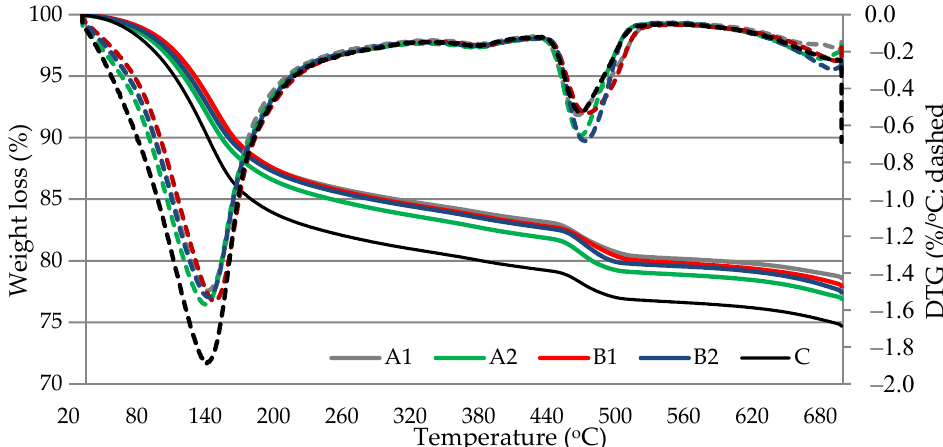
Figure 10. Results of thermal analysis of hardened blended cement paste after 7 days curing.